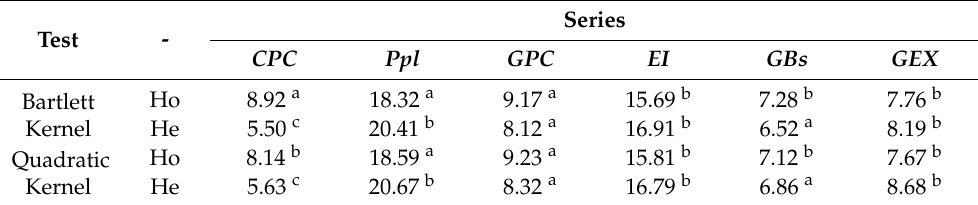
Table 5. Panel unit root test with structural